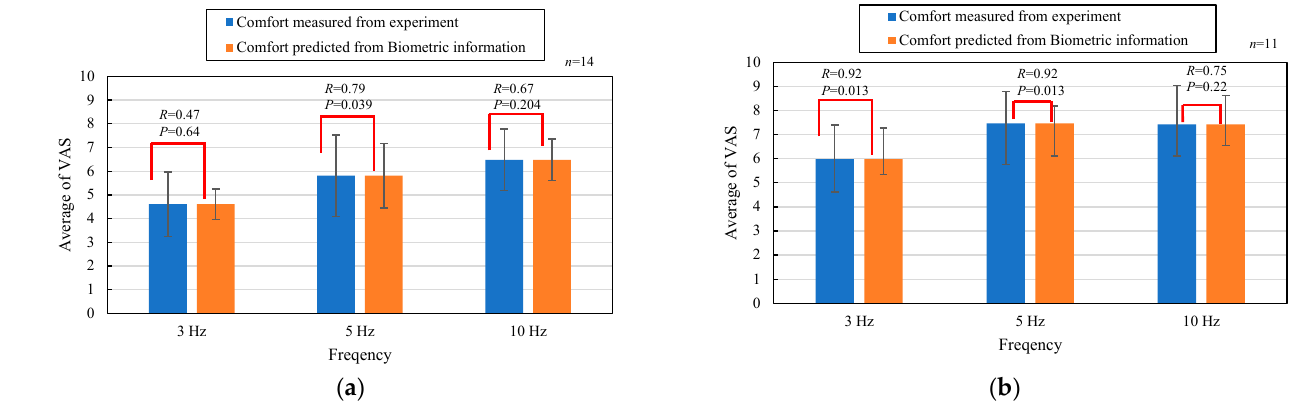
Figure 15. Average and standard deviation of VAS for each group. ( a ) Group A; ( b ) Group B.